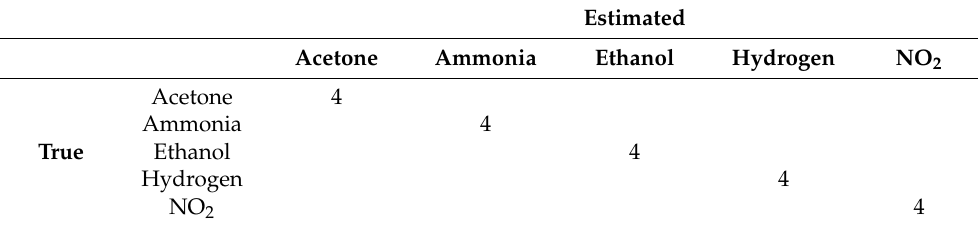
Table 1. Confusion matrix obtained with the sensor based on SnO 2 nanowires. Estimated Acetone